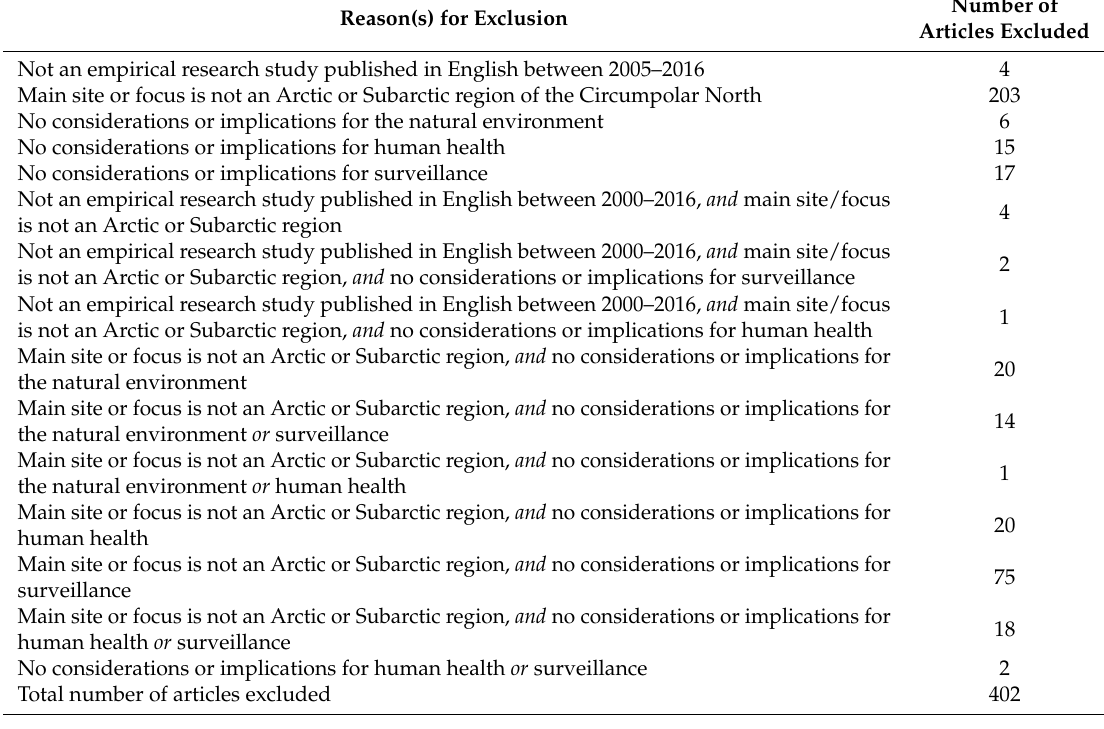
Table A3. Breakdown of the 402 articles that did not meet full-text screening criteria for articles that described integrated surveillance in Circumpolar Arctic and Subarctic regions, and associated reasons for